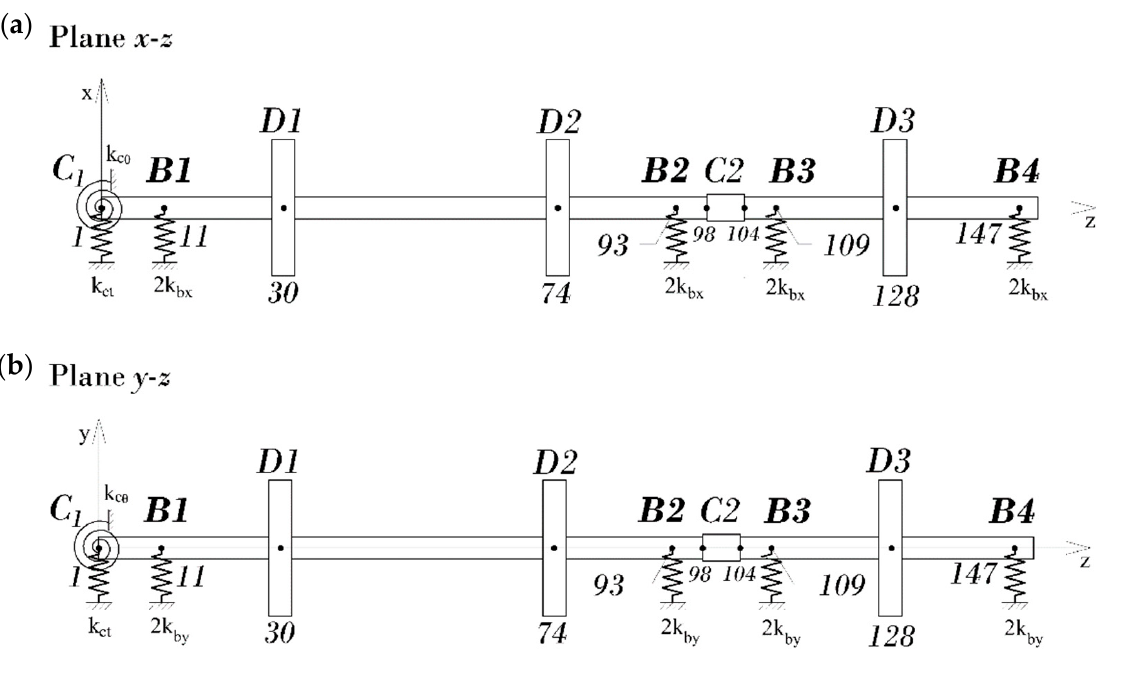
Figure 5. Schematic of FE simulation of the experimental rig. ( a ) Plane x-z. ( b ) Plane